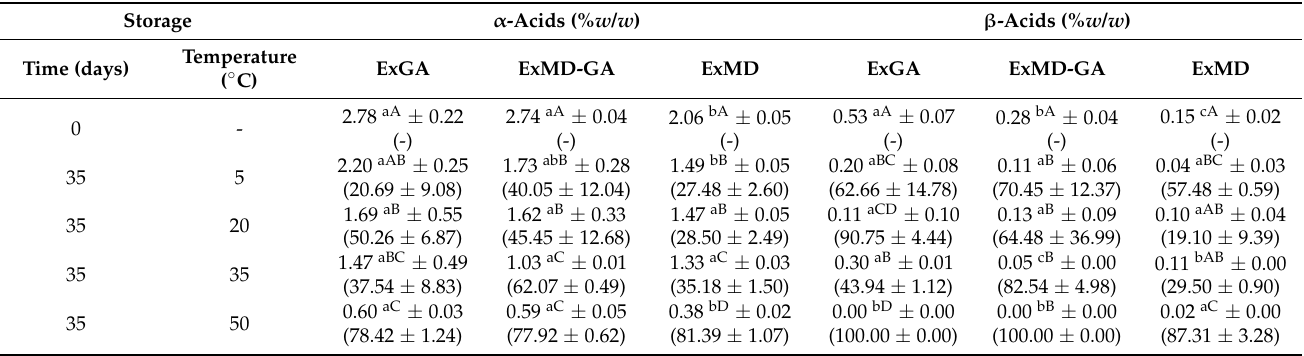
Table 3. Alpha and Beta acids content of differently microencapsulated hop extracts before and after 35 days of storage at different temperatures.